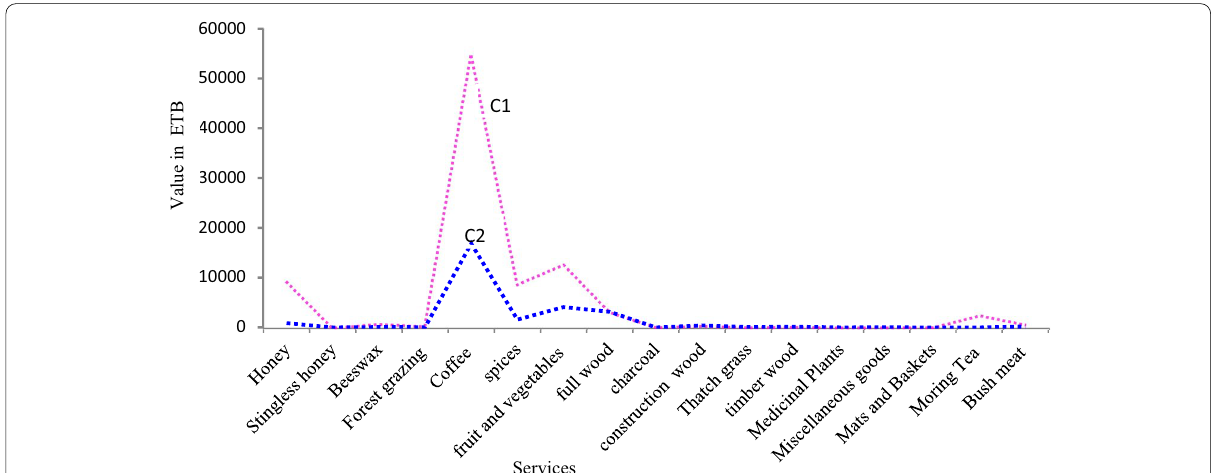
Fig. 2 Demonstrating of forest-related income sources to comparing the relative dimensions within 17 forest products and variation between category (collected by households/year, ETB)